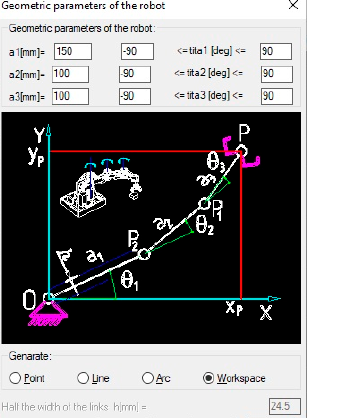
Figure 14. ( a ) Model and ( b ) prototype of a 3D printed educational robot. ( c ) Three-dimensional configuration space divided by types.